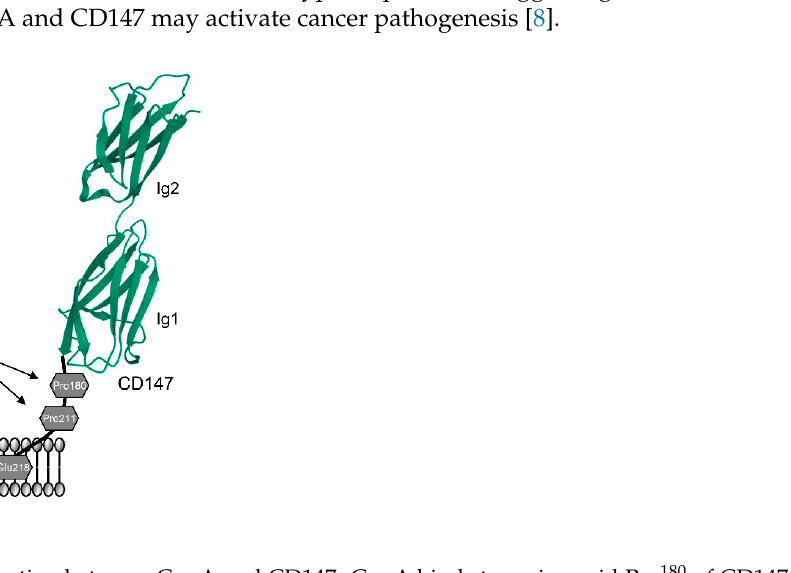
Figure 3. Interaction between CypA and CD147. CypA binds to amino acid Pro 180 of CD147 and induces signal transduction through subsequent interaction with Pro 211 . The amino acid Glu 218 of CD147 is also important for the signaling response.